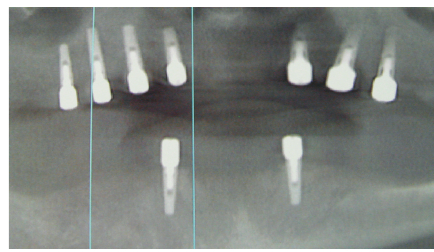
Figure 2: Panoramic radiograph after implant insertion. Figure 3: (a and b) Clinical view of the implants after surgical